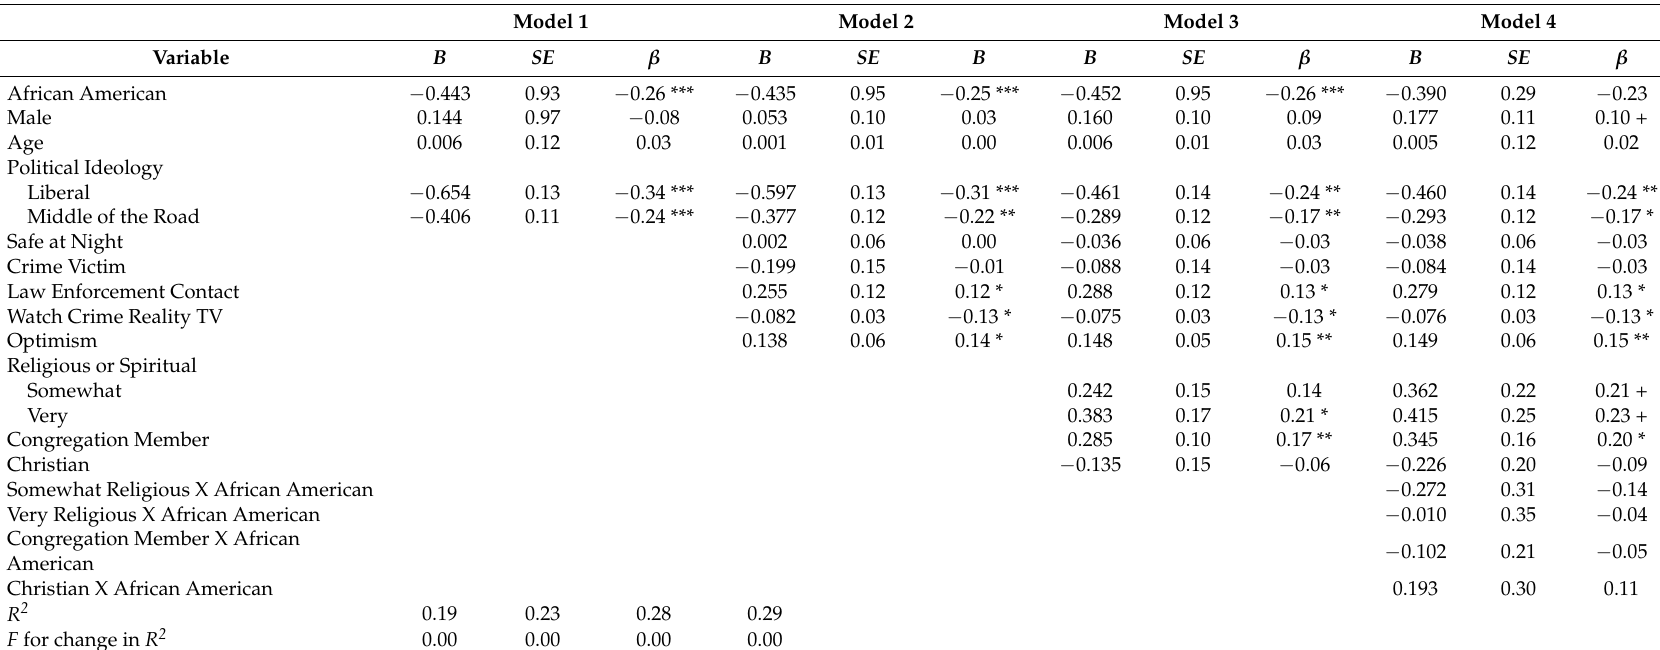
Table 3. Ordinary Least Squares (OLS) Regression Estimates Predicting View of Courts (N =